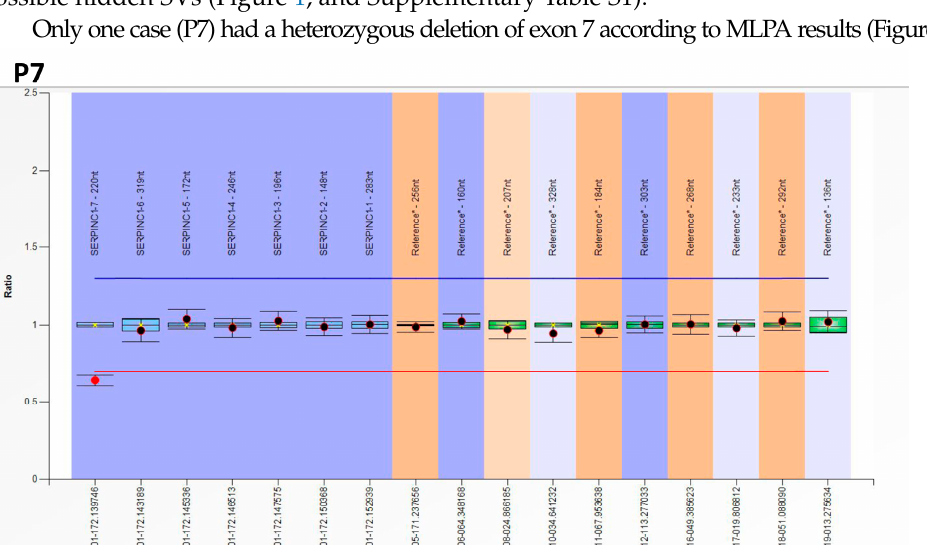
Figure 3. MLPA identification of a heterozygous deletion of exon 7 in patient P7 with antithrombin deficiency who carried a genetic defect previously identified by sequencing all 7 exons and flanking